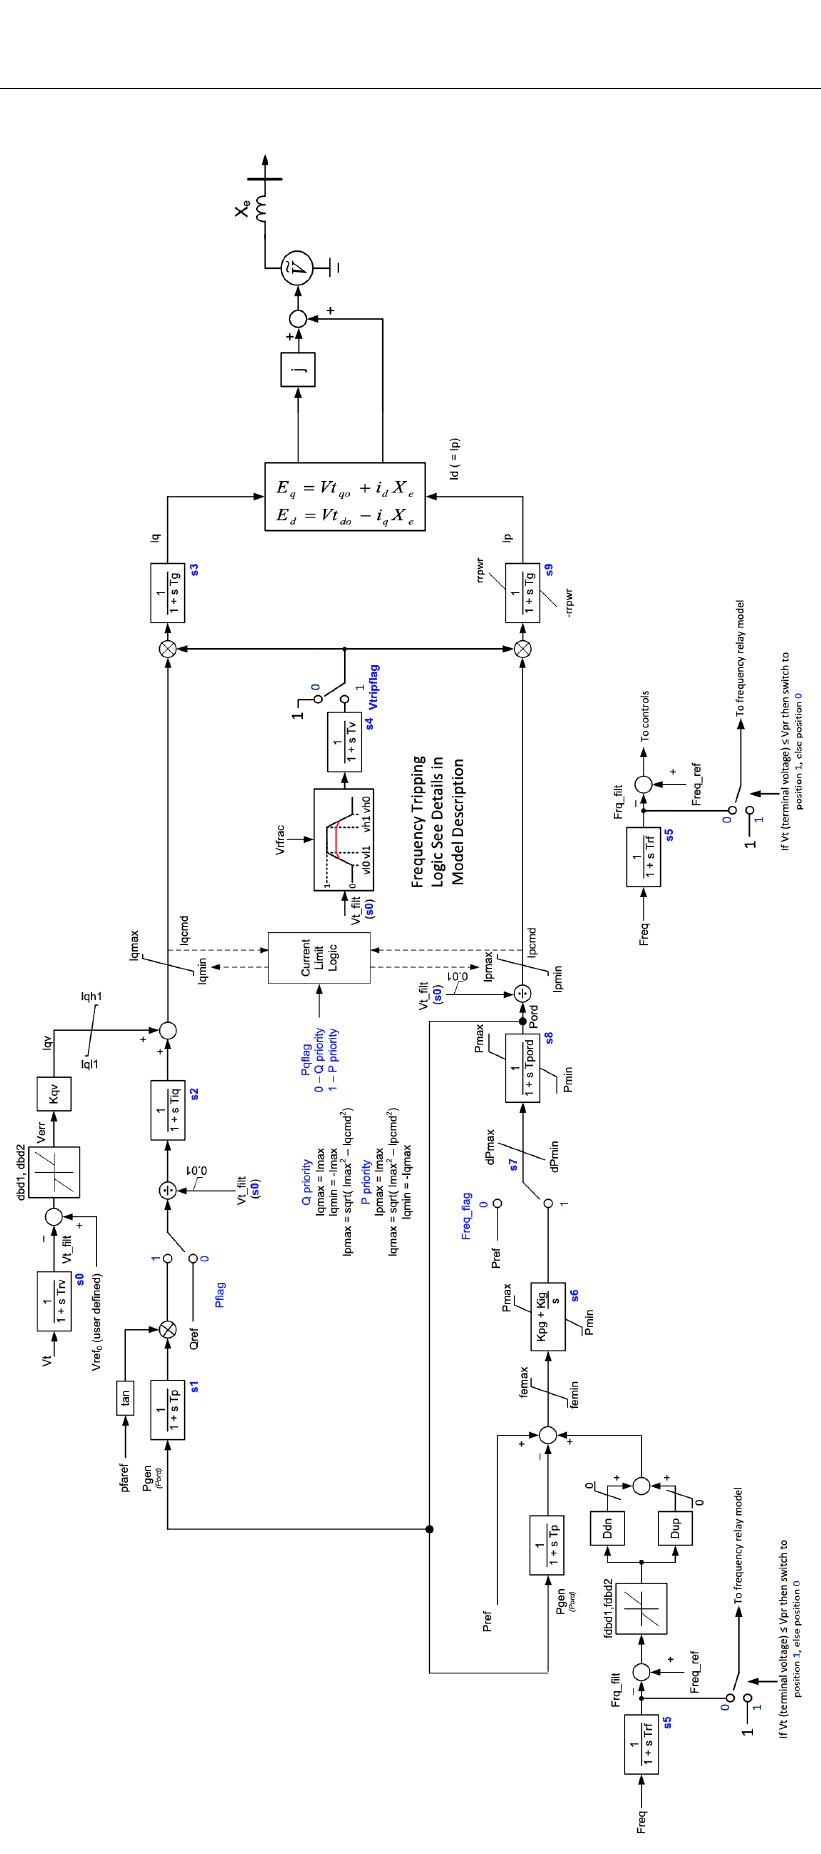
Figure 2. Block diagram for the DER_A model version A